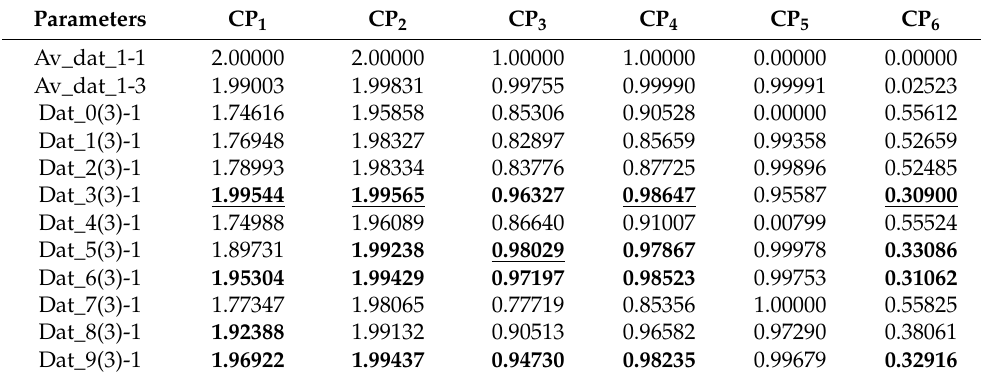
Table 6. The similar parameters for the sensors 1–3. The sensor 1 is selected as the reference